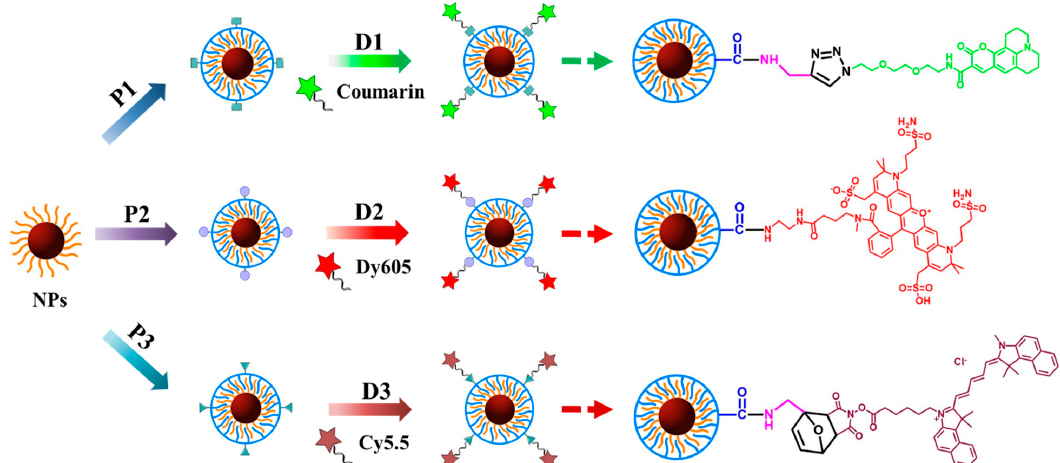
Figure 5. Schematic illustration of the geometry of the used NPs. After the synthesis of hydrophobically capped Fe 3 O 4 NPs, the NPs were over-coated with three different derivatives of the amphiphilic polymer poly-(isobutylene-alt-maleic anhydride)-graft-dodecyl: PMA-Prop (P1), PMA (P2), and PMA-Furf (P3), leading to dispersion in aqueous phase. Afterward, these NPs were conjugated with different fluorophores: Coumarin 343-azide (D1), Dy605-amine (D2), and Cy5.5-maleimide (D3). On the right, a sketch of the respective coupling chemistries is shown.